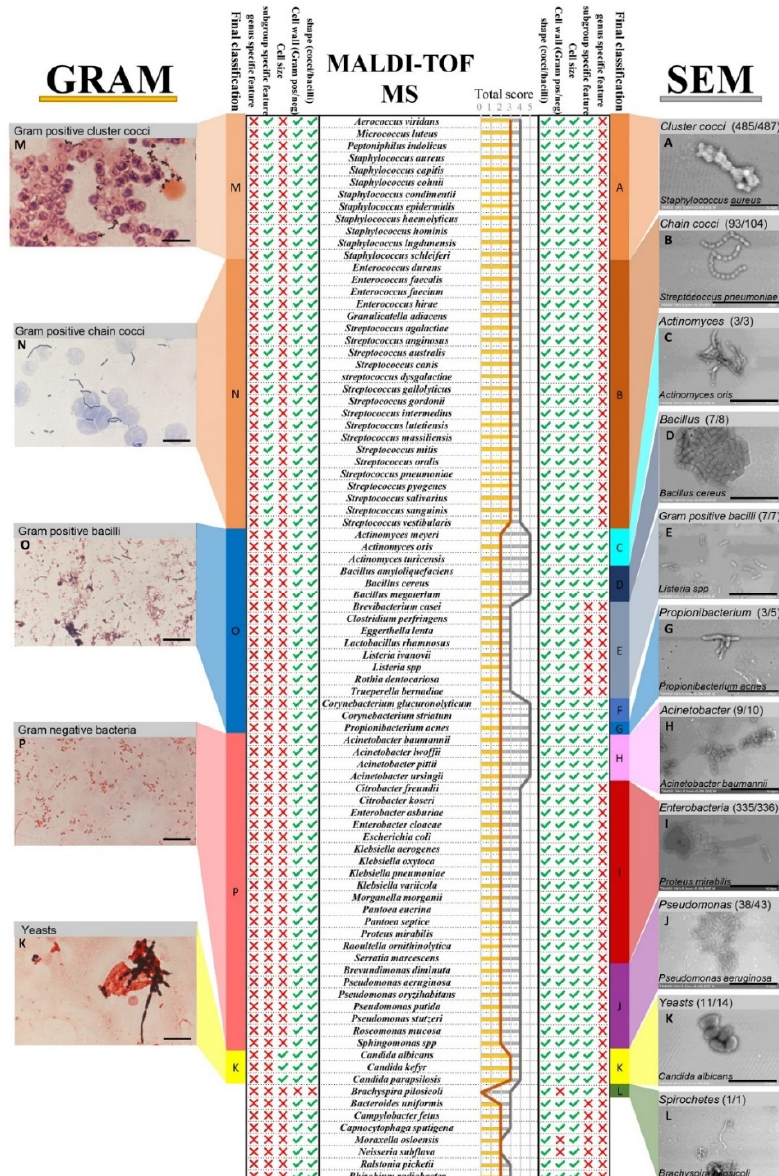
Figure 4. Microbe classification and identification criteria acquired using Gram staining versus SEM with MALDI-TOF/MS as a reference. Identification information (shape, cell wall, cell size, subgroup-specific feature, genus-specific feature) acquired for each of the species is indicated with a tick mark, missing information is indicated with a red cross. The total Scheme 100. artificial blood cultures inoculated with various Acinetobacter sp. and Enterobacteria . We were able to blindly identify 82% of the Acinetobacter according to the presence of these structures.